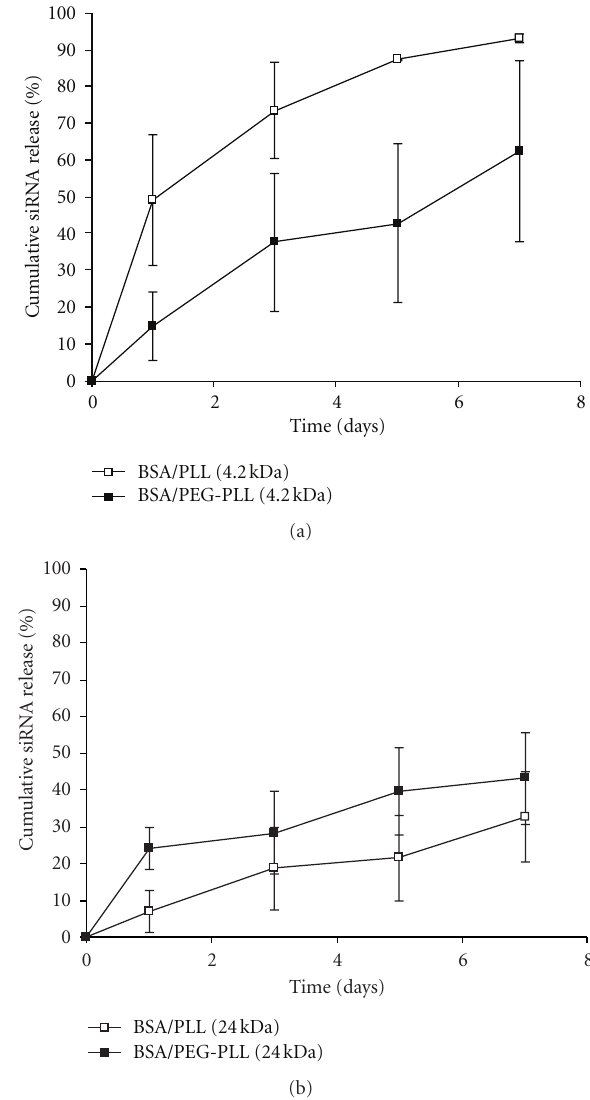
Figure 2: Cumulative siRNA release profile for 4.2 kDa (a) and 24kDa (b) PLL-based coatings, over seven days. Trend lines are provided as a guide to the eye only. Data points represent an average ± 1 SD, n ≥